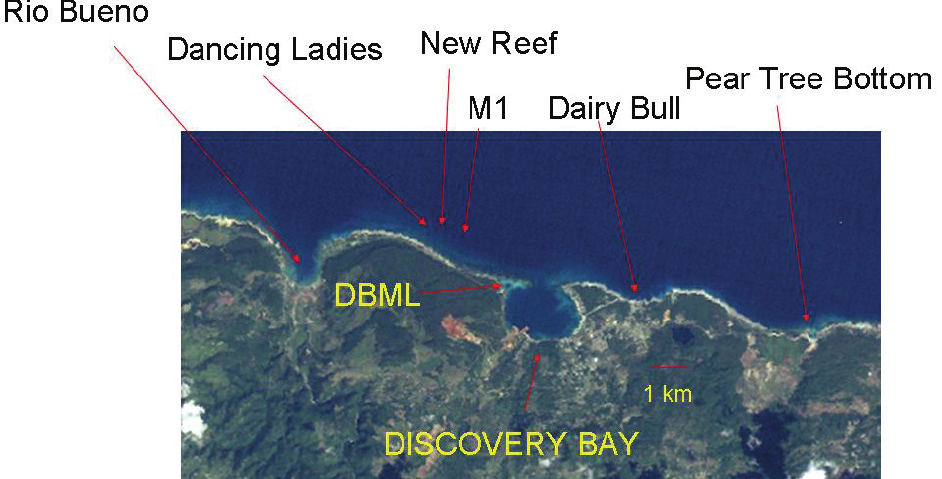
Figure 1. Satellite image showing the location of fringing reef sites (Rio Bueno, M1, New Reef, Dancing Ladies, Dairy Bull and Pear Tree Bottom) around Discovery Bay, Jamaica. DBML, Discovery Bay Marine Laboratory. The horizontal line shows 1 km